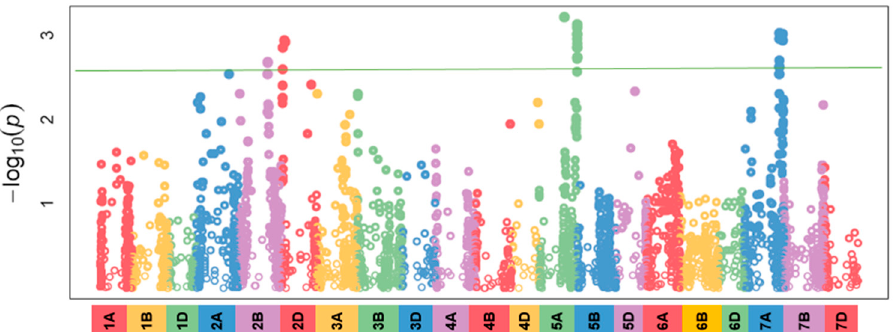
Figure 3. Manhattan plot, best linear unbiased prediction (BLUP) values of infection on the 21st day after inoculation, across years and study sites, according to the chromosomal localization of the markers (significance level: -log 10 ( p ) 2,5; Martonvásár, 2006, 2007, 2009, 2011).